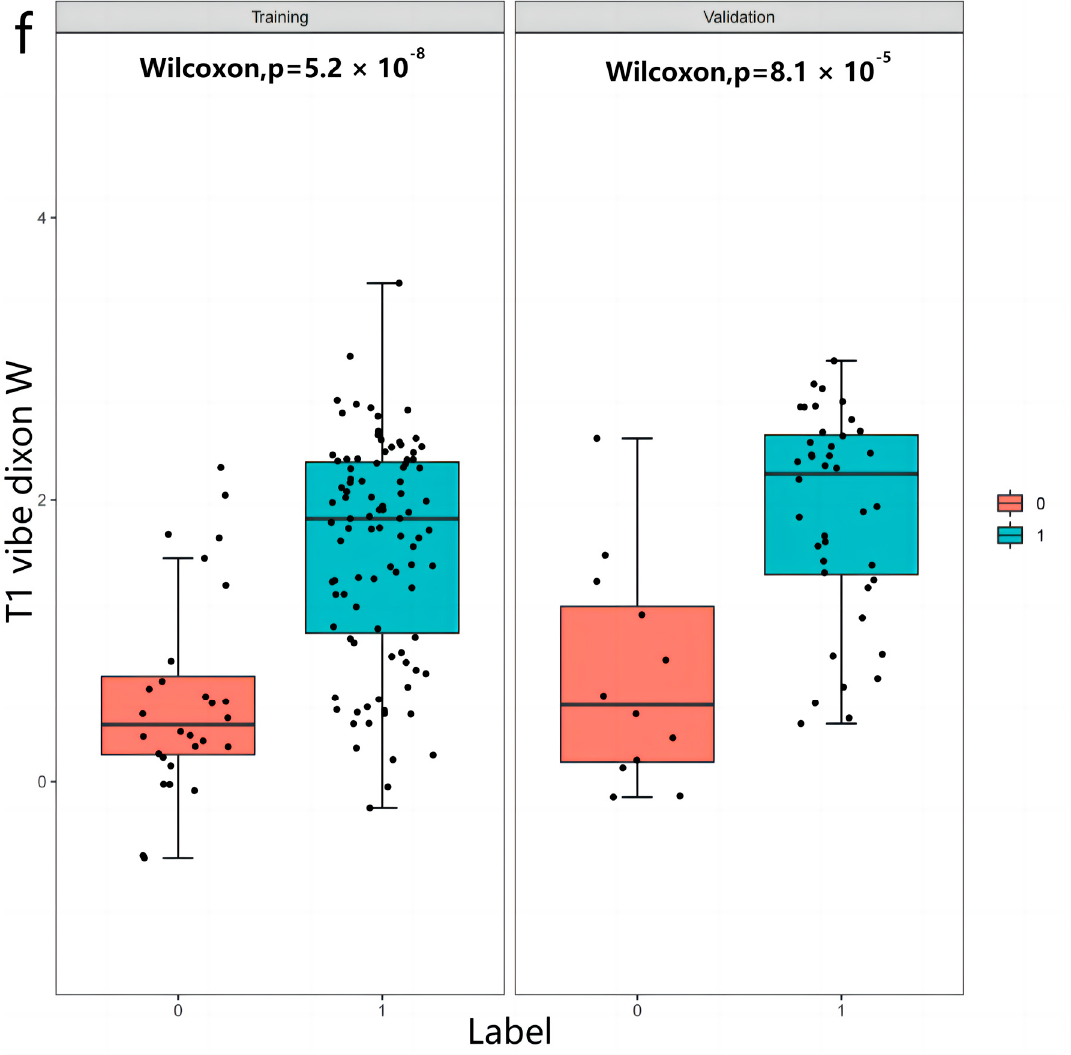
Figure 6. ( a ), ( b ), ( c ), ( d ), ( e ), and ( f ) represent the Rad score distributions of the training group and Figure 6. ( a – f ) represent the Rad score distributions of the training group and the validation group the validation group in the T2, T2*, T1 vibe dixon opp, T1 vibe dixon in, T1 vibe dixon F, and T1 in the T2, T2*, T1 vibe dixon opp, T1 vibe dixon in, T1 vibe dixon F, and T1 vibe dixon W models, vibe dixon W models, respectively. Box plots showed significant differences in Rad scores between respectively. Box plots showed significant differences in Rad scores between Label 0 ( α - genome) and Label 0 ( α - genome) and Label 1 ( β - genome) in different models ( p < 0.05). Label 1 ( β - genome) in different models ( p <